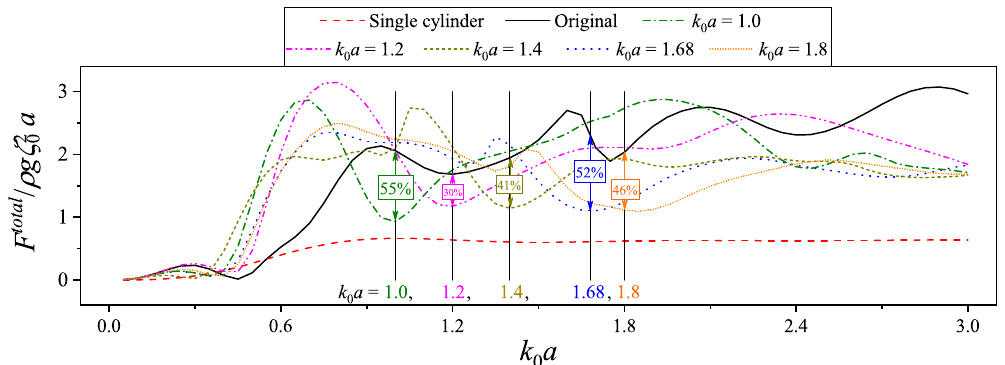
Figure 21. The total wave drift force for the original structure and the optimized